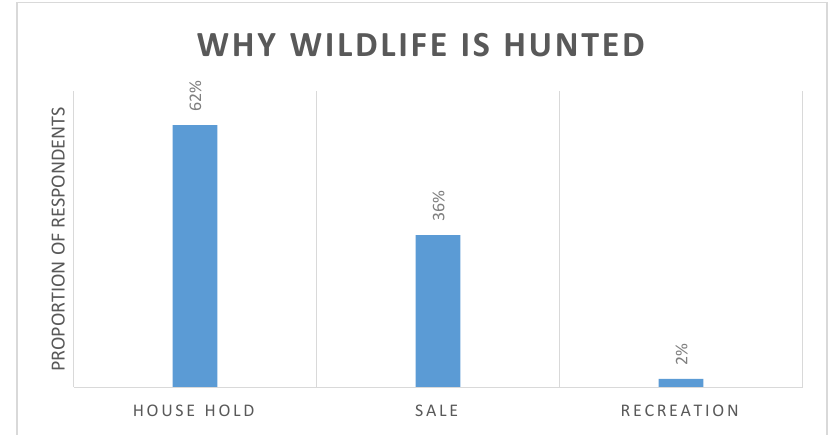
Figure 3. Distribution of responses regarding the drivers for illegal hunting of wildlife in the northern section of Bardia National Park, Nepal ( n = 42).